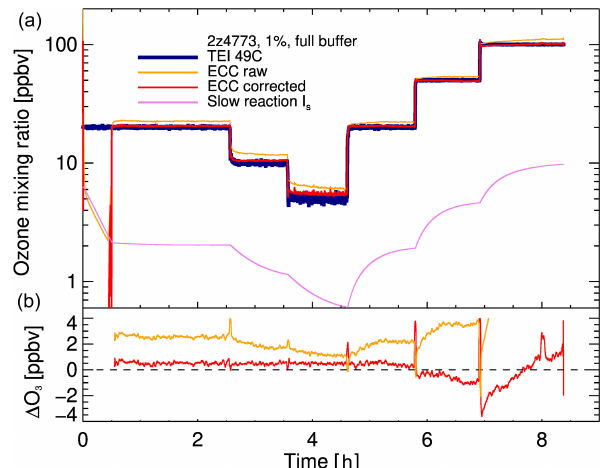
Figure 1. Top: ozone mixing ratio generated by the TEI 49C ozone calibrator (blue) and measured by the ECC (original processing in orange, time-response-corrected in red). The contribution of the slow reaction is shown in purple. Bottom: difference of raw (or- ange) and corrected (red) ECC measurements from TEI 49C ozone